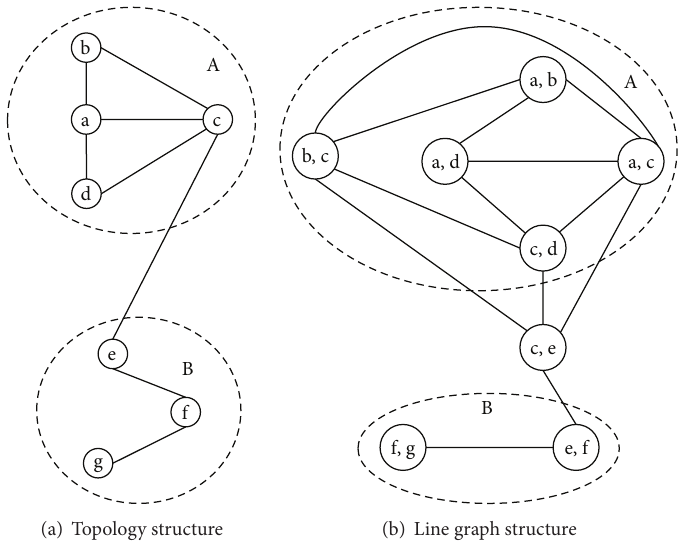
Figure 1: Network topology structure and line graph structure with 7